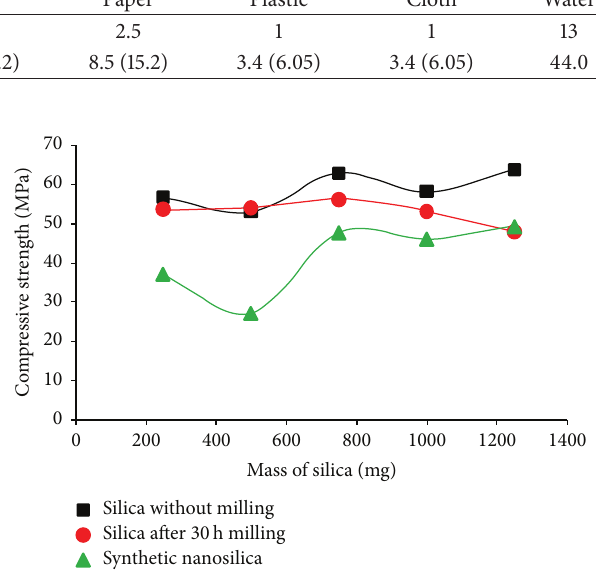
Figure 8: Effect of the silica mass on the compressive strength: (a) nanosilica, (b) rice husk, and (c) rice husk after 30 hours of